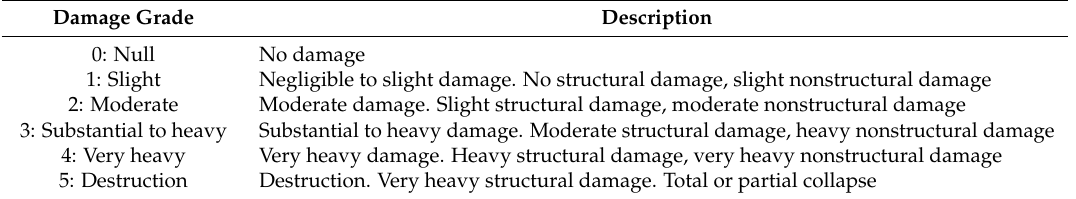
Table 2. Mean damage grade defined in the RISK-UE LM1 method